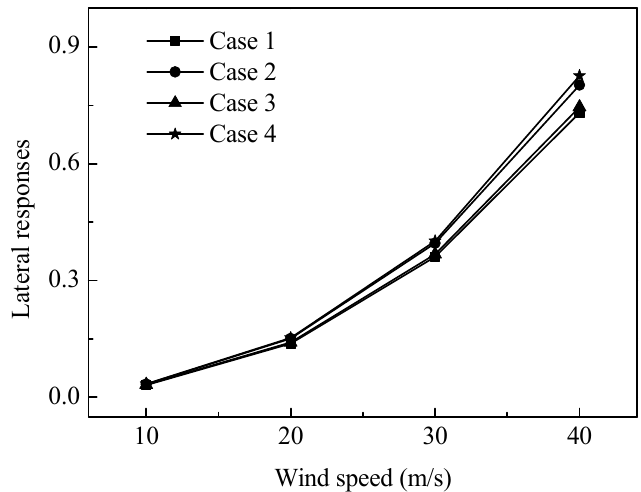
Figure 7. The variance of responses of the bridge deck at the different wind speeds.